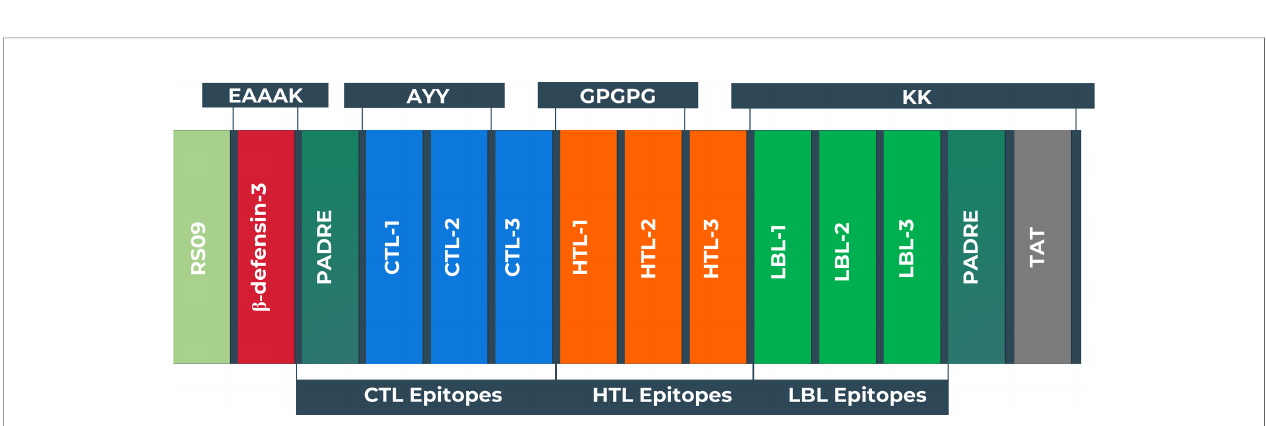
FIGURE 3 | The CTL, HTL, and LBL epitopes were fully conserved across all the chosen virulent fungi and satis fi ed all the selection criteria: antigenicity, allergenicity, non-toxic, cytokine inducing ability. The red boxes indicate the epitopes.